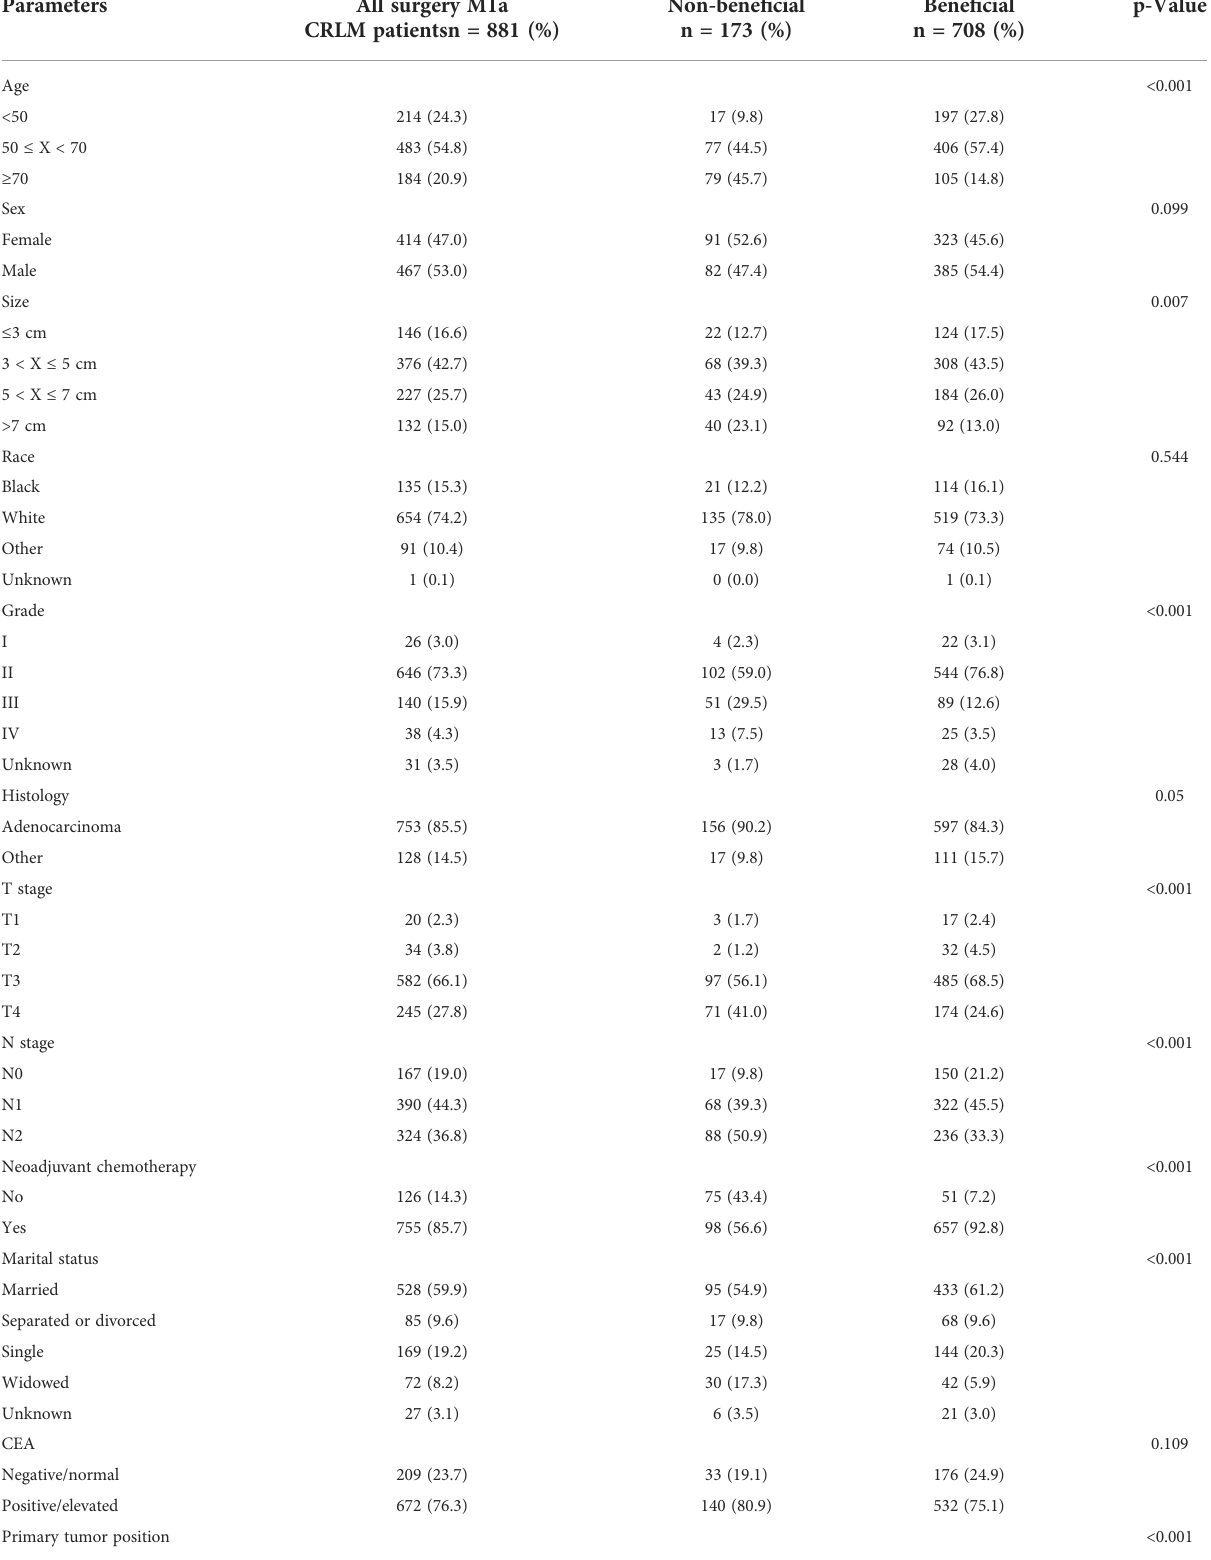
TABLE 2 Characteristics of M1a CRLM patients who bene fi t from the surgery.